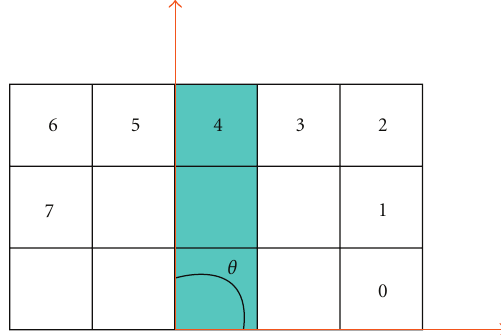
Figure 4: Extraction of the edge-direction distribution using 8 angles.